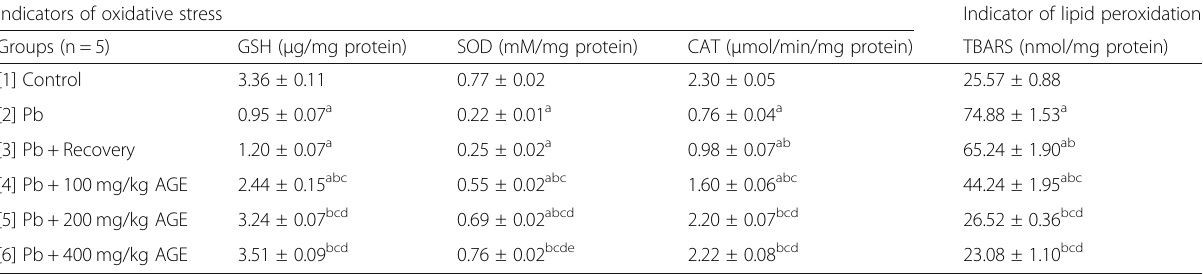
Table 7 Effects of AGE on kidney indicators of oxidative stress and lipid peroxidation in Wistar rats with Pb-induced kidney injury Indicators of oxidative stress Indicator of lipid peroxidation Groups (n =